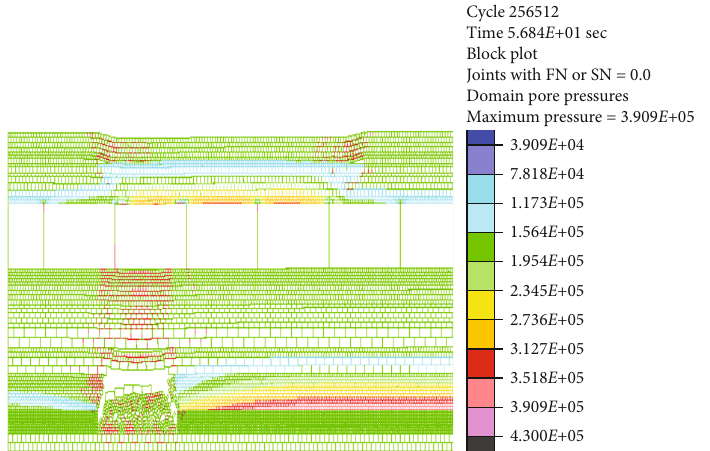
Figure 6: The pore pressure distribution in initial caving of key layer